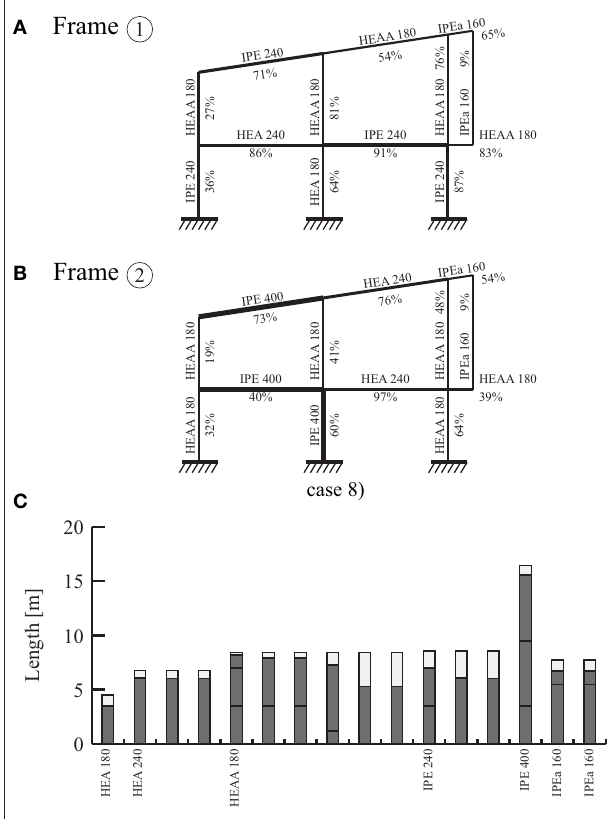
FIGURE 10 | Optimal design for case 8: (A,B) optimal cross-sections for frames ‹ and › respectively, (C) cutting pattern of reused stock elements.